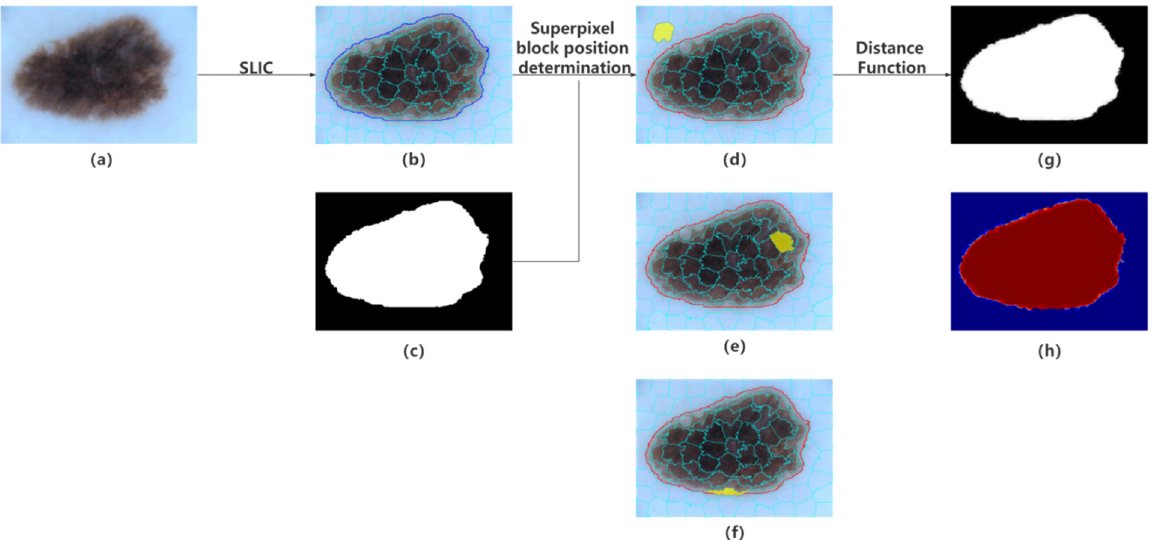
Figure 4. Pipelines for generating soft labels. ( a ) Original image. ( b ) Superpixels map. ( c ) Hard Ground truth. ( d – f ) Illustration of relations between the boundary and a superpixel block. ( g ) Soft Ground truth. ( h ) Colormap of soft Ground